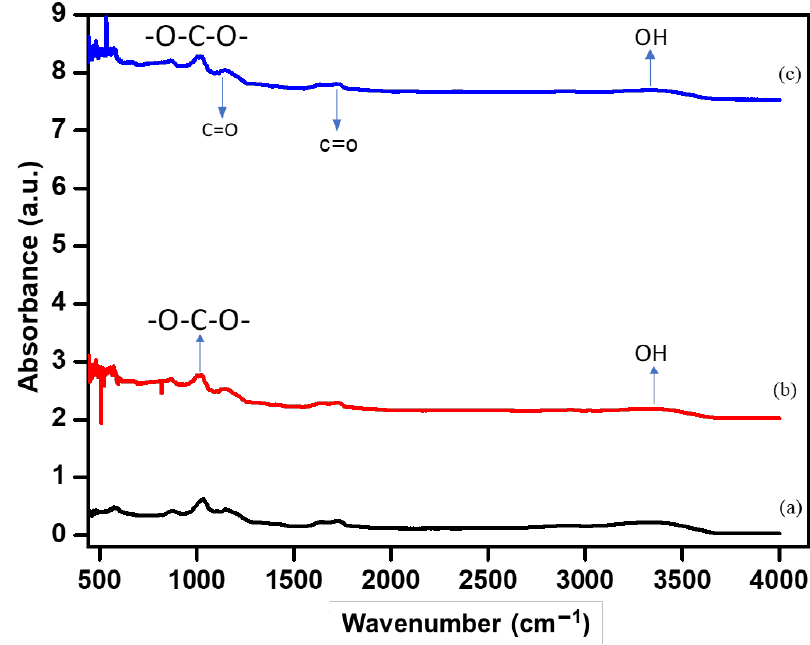
Figure 3. The FT-IR spectrum of the ( a ) alginate and ( b , c ) A/P:P